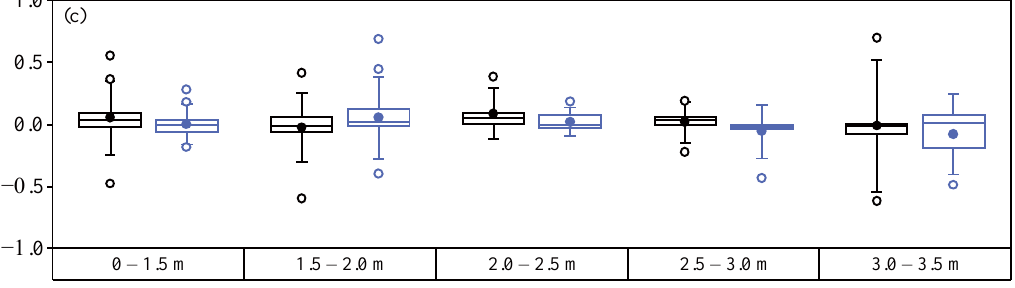
Figure 5. Relationship between the changes in root zone soil salinity in the crop growing season in the dry year of 2017 (Black boxplot) and wet year of 2018 (Blue boxplot) with ( a ) crop type, ( b ) root zone soil salinity at the beginning of the crop growing season, and ( c ) average groundwater table depth in the crop growing season.